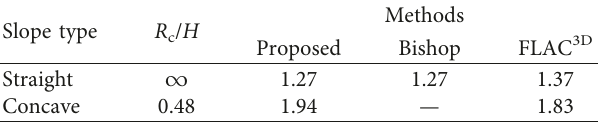
Table 2: Comparison of the FoS obtained by different methods.